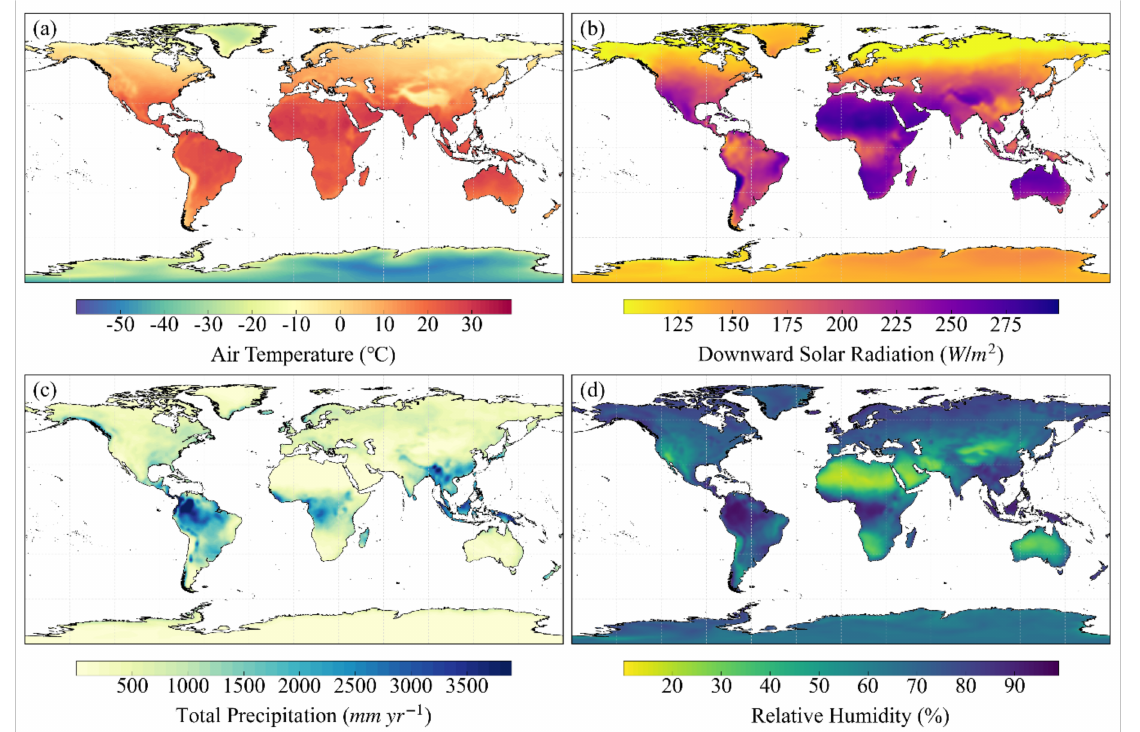
Figure 1. Global distribution of meteorological variables in 2015: ( a ) mean hourly air temperature in ◦ C; ( b ) mean hourly downward solar radiation in W m − 2 ; ( c ) annual total precipitation in mm yr − 1 ; ( d ) mean hourly relative humidity. Global means of air temperature, downward solar radiation, precipitation, and relative humidity for 2015 were 4.1 ◦ C, 76.3 W m − 2 , 303 mm yr − 1, and 25.8%,